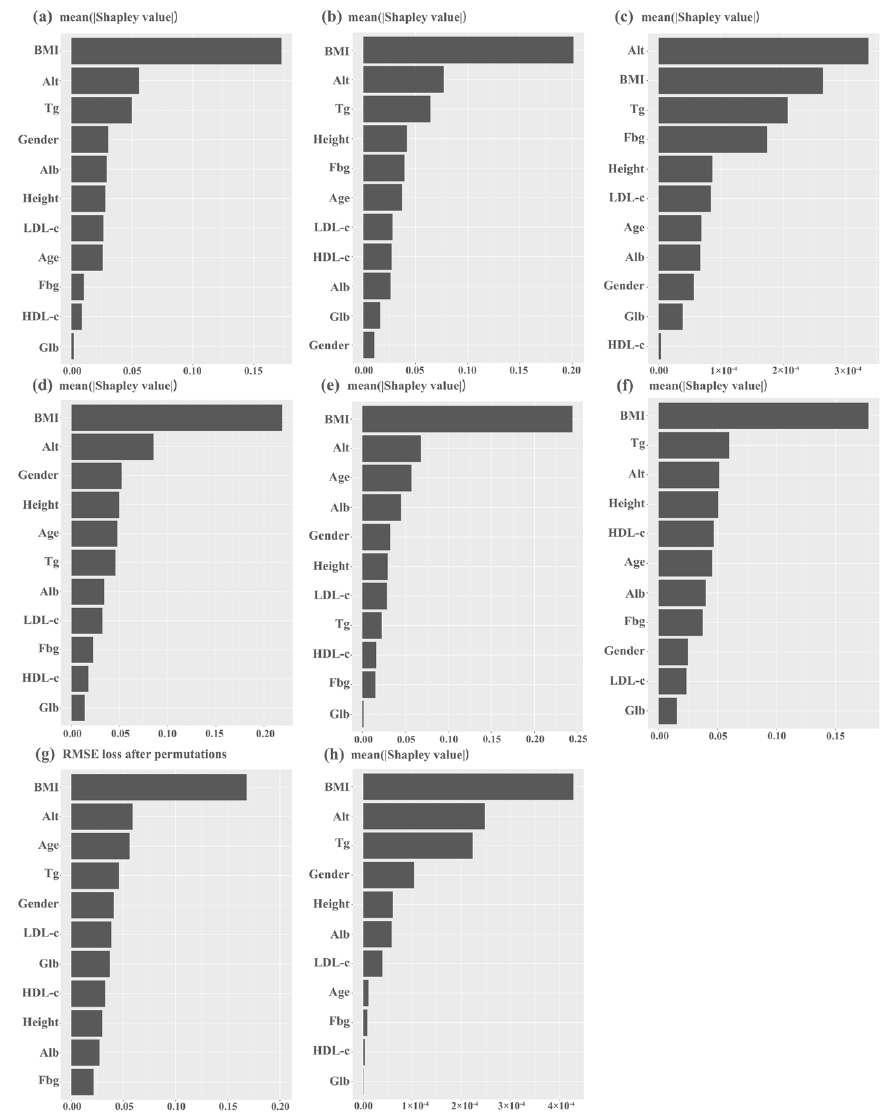
Figure 4. Feature importance analysis of all machine learning models: ( a ) logistic regression; ( b ) random forest; ( c ) extreme gradient boosting; ( d ) support vector machine; ( e ) linear discriminant analysis; ( f ) quantitative descriptive analysis; ( g ) k -nearest neighbor; and ( h ) artificial neural network.